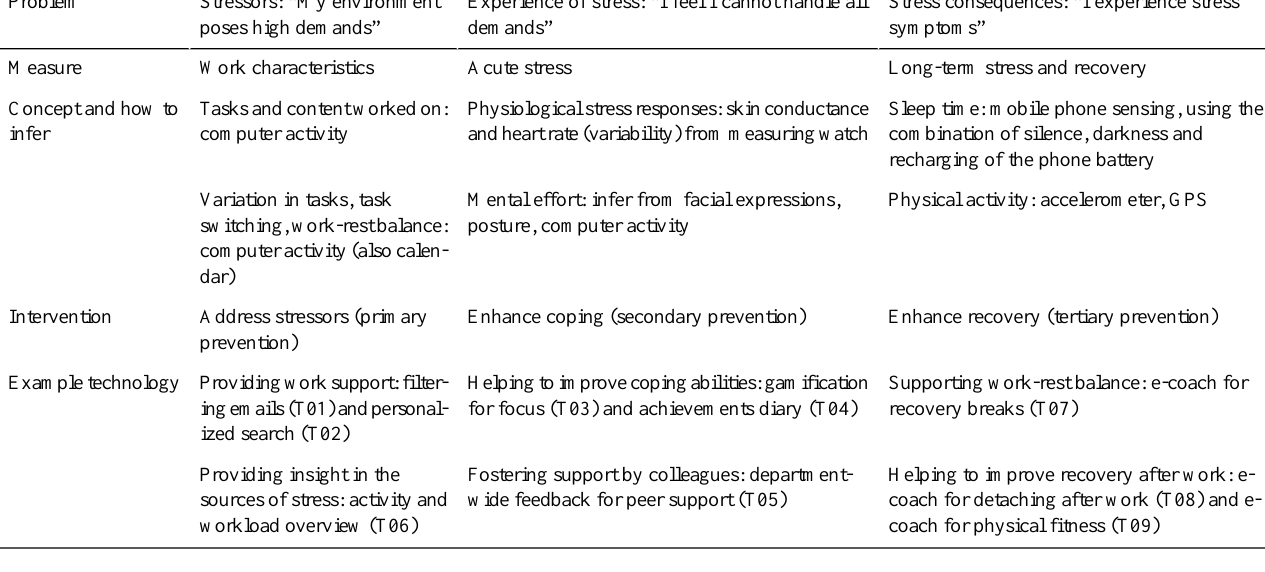
Table 2. Overview of the three aspects in the stress chain (from left to right). For each aspect, several indicative factors can be measured and different technology-based interventions can be provided